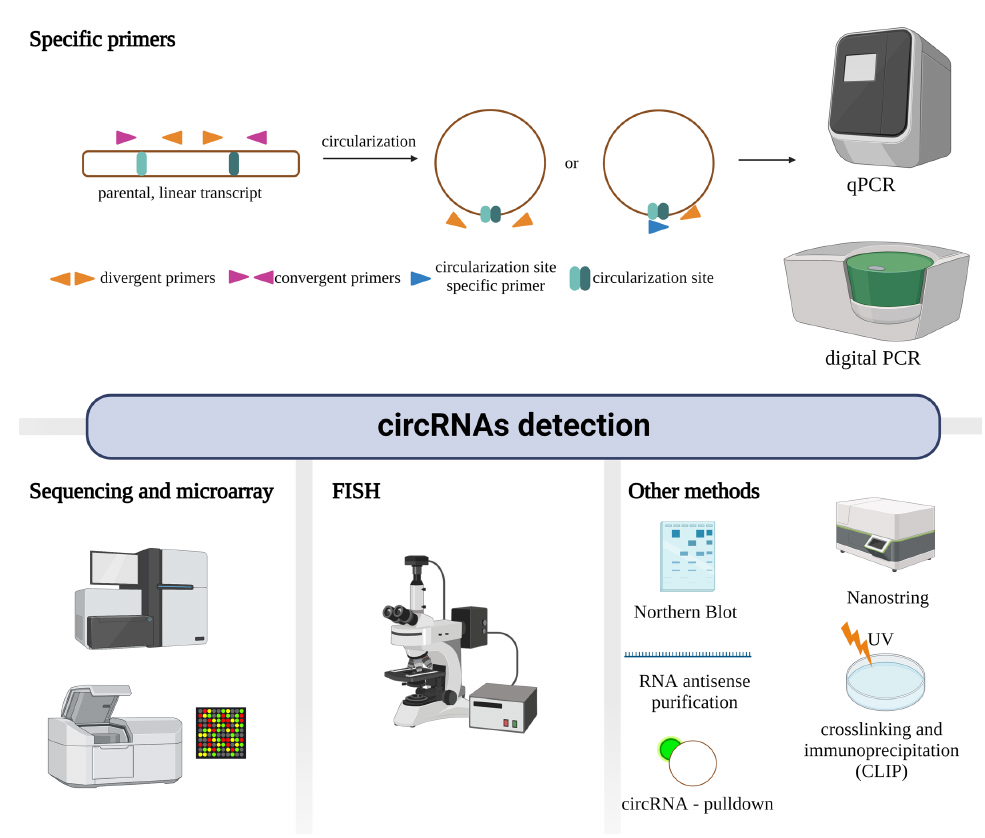
Figure 3. Summary of methods used to study circRNAs expression. The most commonly used meth- ods for circRNAs detection are qPCR and digital PCR, which require primers (upper panel) that are specific for circRNAs’ unique sequence. Methods of global circRNA analysis, including sequencing, microarray, and Nanostring™ platform, are shown on the lower panel.